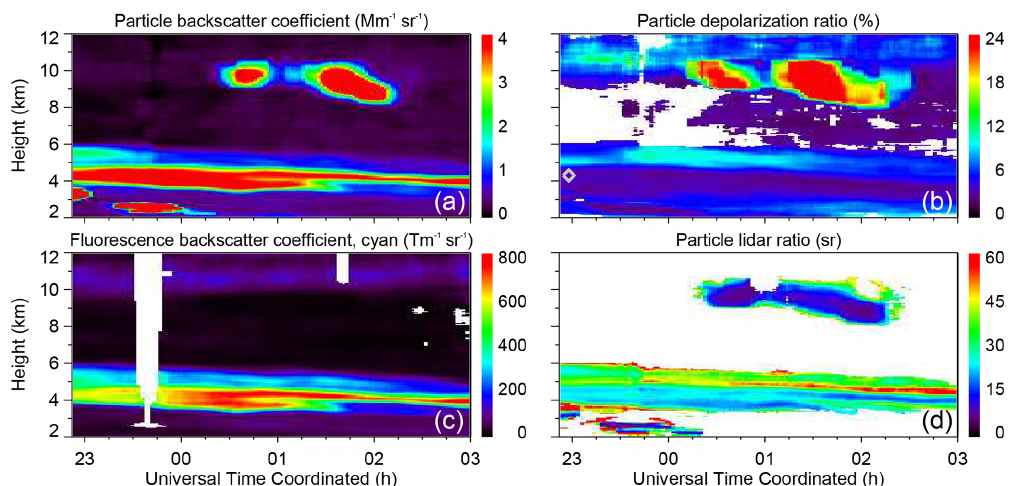
Figure 6. Temporal evolution of (a) particle backscatter coefficient, (b) particle depolarization ratio, (c) fluorescence backscatter coefficient (cyan false color), and (d) particle lidar ratio (not corrected for multiple scattering) as measured with RAMSES in the night of 9–10 August 2021 between 22:50 and 03:00UTC. The spectrum measured at 4.3km around 22:58UTC (gray symbol, panel b ) is analyzed in Fig. 7.